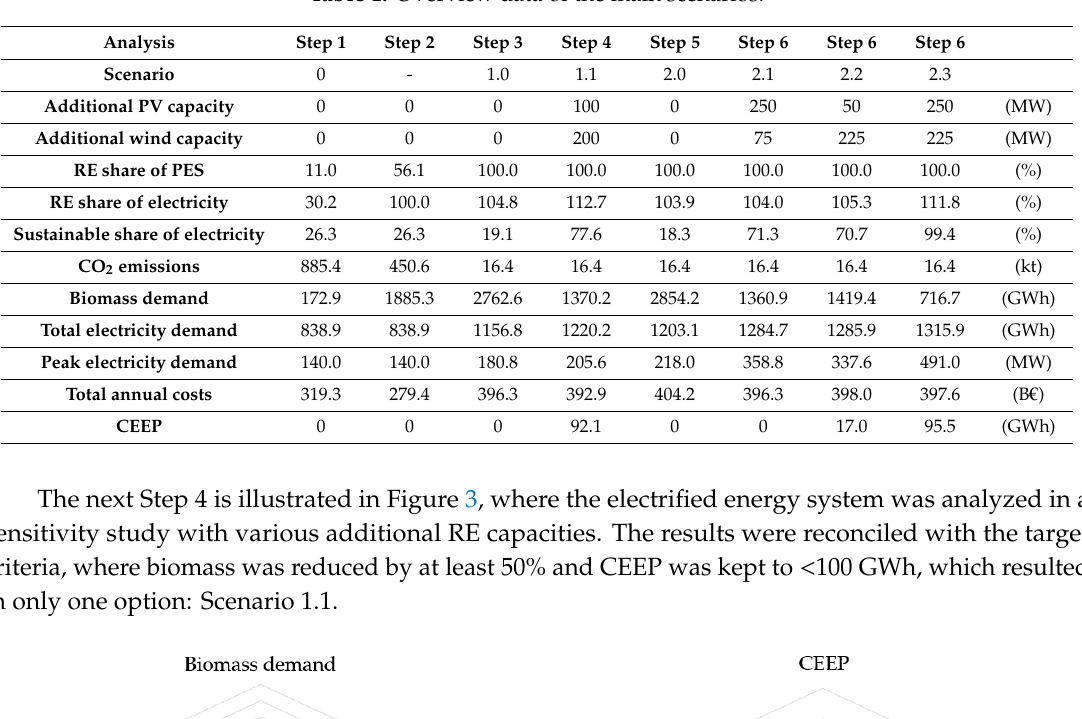
Table 1. Overview data of the main scenarios.